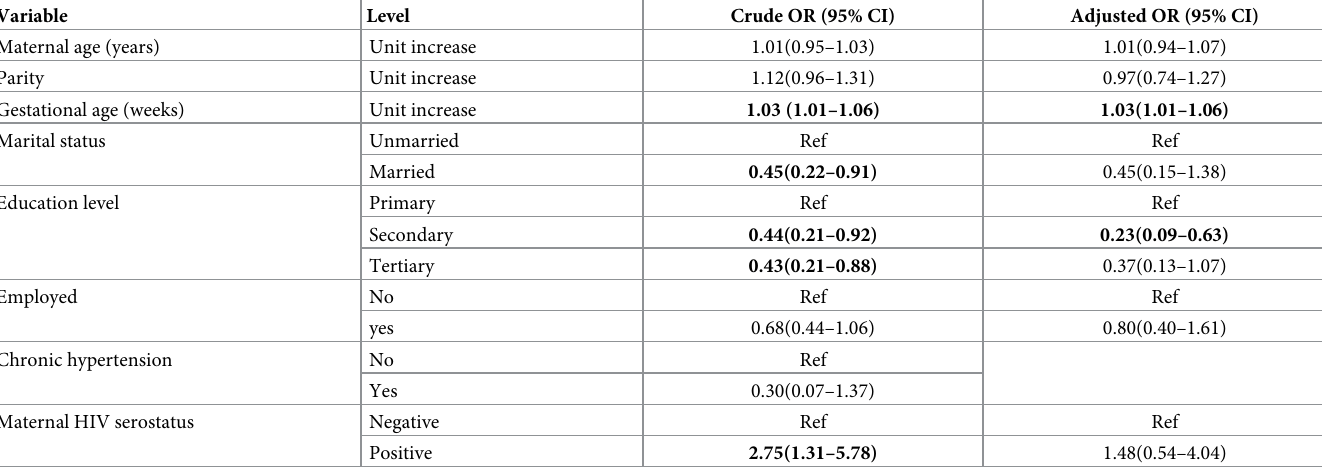
Table 2. Multivariable logistic regression of factors associated with COVID-19 infection among pregnant women.